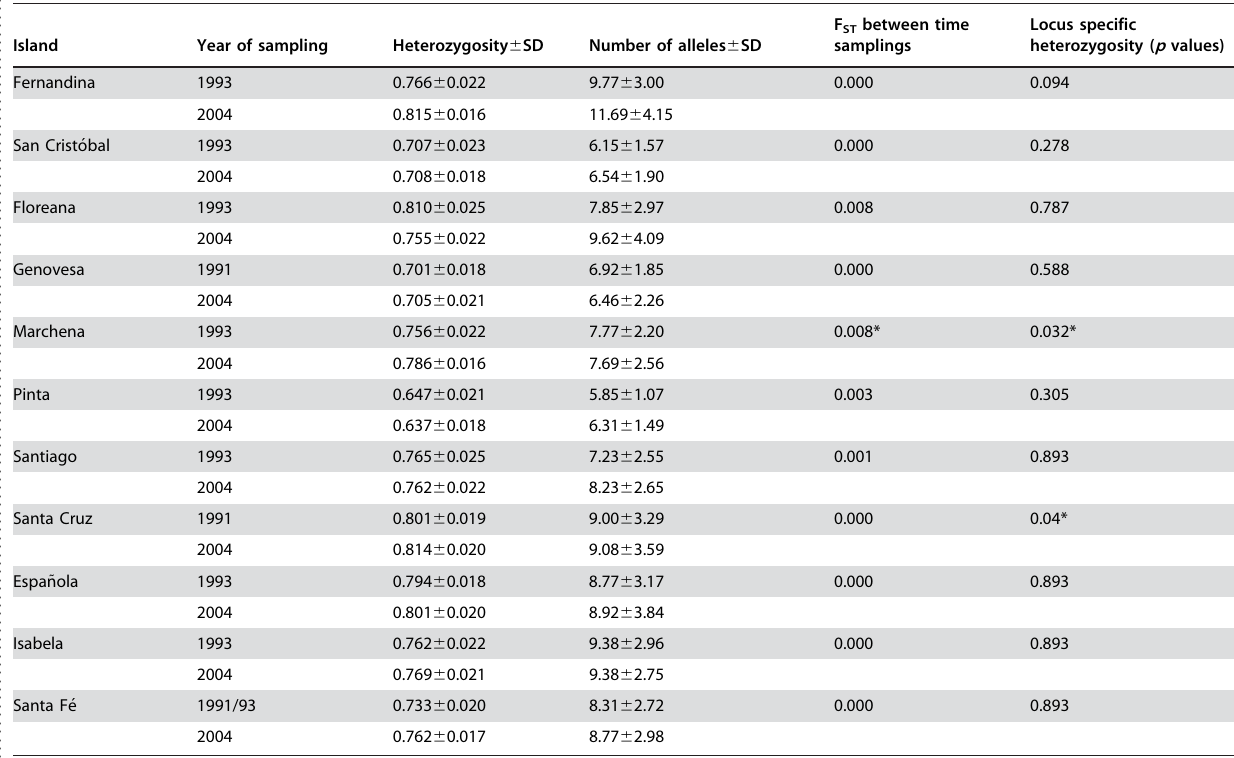
Table 1. Summary analysis of the 13 microsatellite loci used in this study. .. ... .... ... ... .... ... ... .... ... ... .... ... ... .... ... ... .... ... ... .... ... ... .... ... ... .... ... ... .... ... ... .... ... ... .... ... ... .... ... ... .... ... ... . Island Year of sampling Heterozygosity 6 SD Number of alleles 6 SD